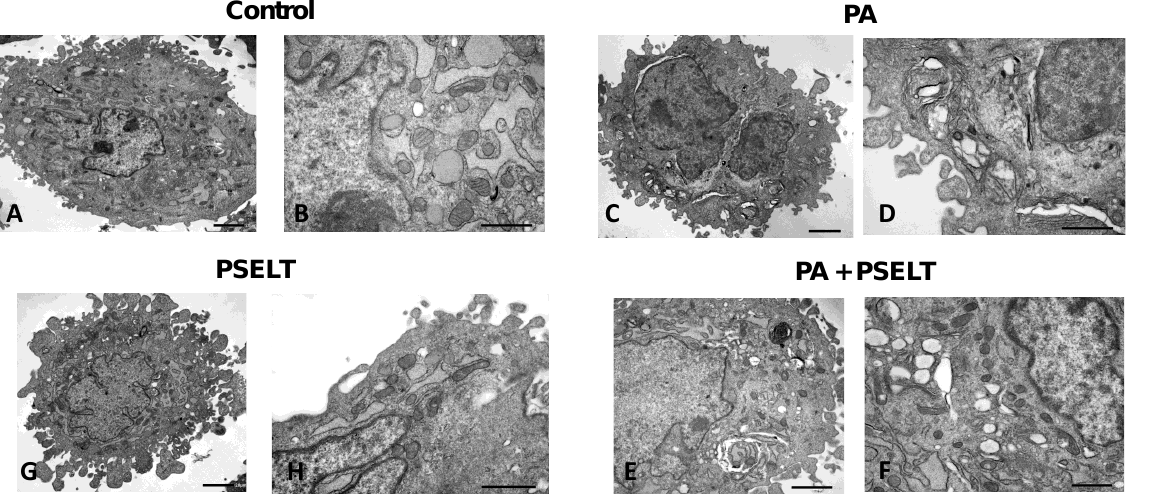
Figure 6. Representative images of transmission electron microscopy (TEM) regarding the effect of PA and PSELT, alone and in combination, on H9c2 cell ultrastructure. Transmission electron micrographs of control cells with intact architecture of cellular organelles, normal mitochondria with distinct cristea, and dilated ER profiles ( A , B ). PA treatment led to reorganization of the ER into concentrically whorled membranes that in some instances wrapped around degenerated mitochondria with swollen cristae ( C , D ). The beneficial effect of PSELT treatment was revealed by improved cell ultrastructure. ER membranes showing the ultrastructure of their naïve counterparts; mitochondria had highly organized cristae with regular thickness and electron density ( E , F ). PSELT treatment alone did not affect the regular arrangement of the intracellular structures and organelles ( G , H ).